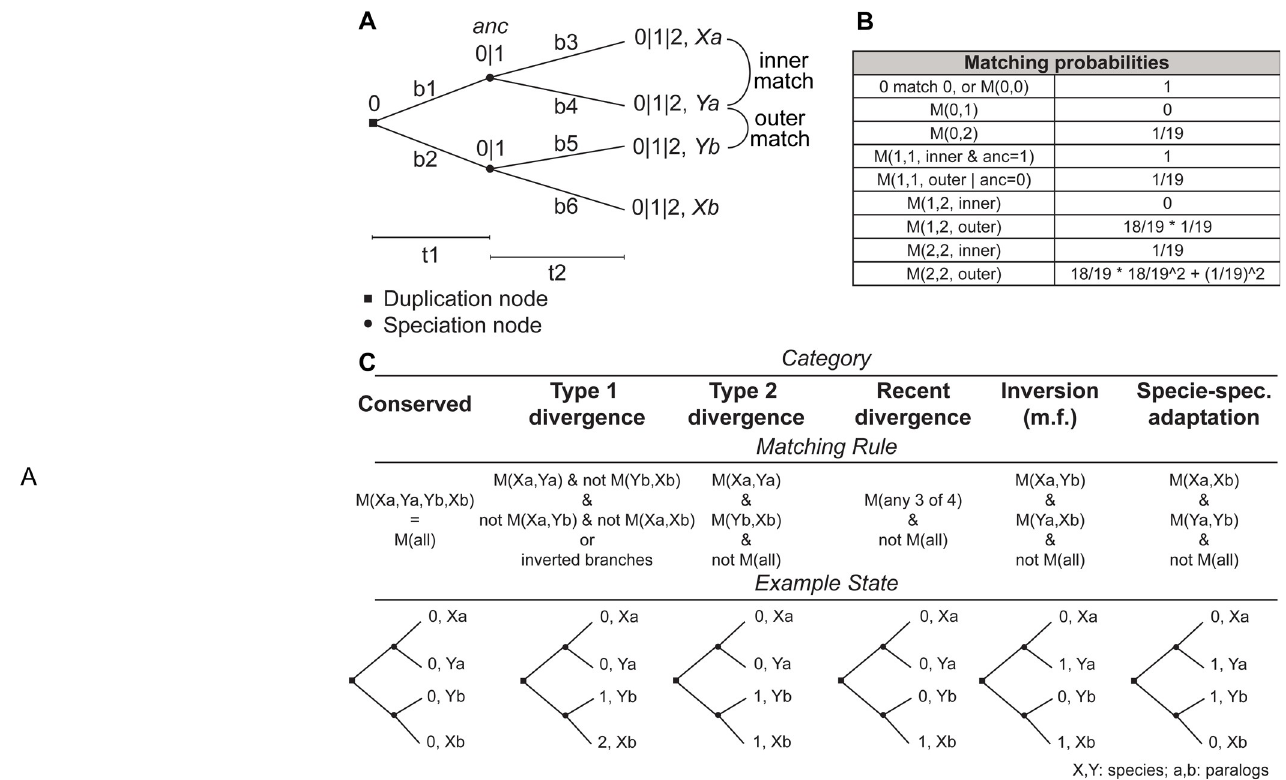
Fig 1. Theoretical model of the evolution of protein site after gene duplication. (A) The structure of the phylogenetic tree that the model is based on. The branch lengths t1 and t2 are used to determine the probability of a substitution on each branch b1 to b6. A leaf node can be found in states 0, 1, or 2 depending on the number of mutations in the preceding branches. An inner match is defined to be a match between orthologs (Xa to Ya, or Xb to Yb), while an outer match is any other match. The probability for a match between two states is given by the table in (B) and represents the underlying transition to any of the 20 amino acids. (C) Description of the categories. The categories represent a biologically interpretable situation, suggested by their name. Given a certain outcome configuration of states, it is possible to calculate the probability of observing a certain category by using the matching rule. The “Example State” section shows the leaf configuration that gives the highest probability of observing the category